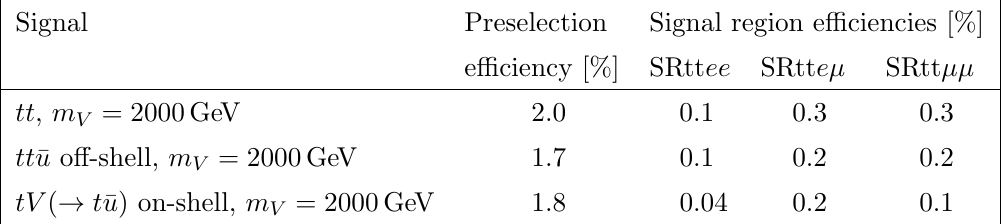
Table 5 . Signal selection and preselection e(cid:14)ciencies for events in the three same-sign top-quark pair production processes, as estimated from MC simulation.